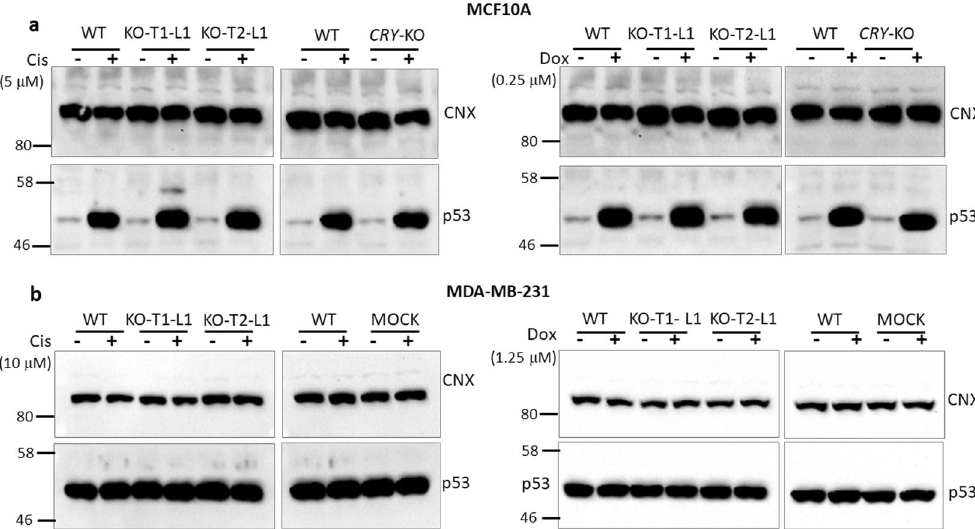
Figure 4. The effect of BMAL1 knockout mutation on p53 protein accumulation following cisplatin or doxorubicin treatment. ( a , b ) MCF10A and MDA-MB-231 cells express wild-type and mutant p53 proteins, respectively. BMAL1 mutation causes an increase in apoptosis in both cell lines while wild-type p53 accumulates at similar levels in wild-type and BMAL1 (as well as CRY -DKO) knockouts in MCF10A clones. A similar increase in apoptosis by BMAL1 mutations in untransformed (a) and transformed (b) suggests that this event is independent of the transformation status of the cells. A mock subclone (transduced with BMAL1 -targeting lentivirus but with wild-type BMAL1 ) of MDA-MB-231 was used as a control instead of CRY -DKO, because CRY -DKO on a p53 mutant background caused an increase in cisplatin-induced apoptosis in MDA-MB-231 cells, in agreement with previous reports (see Supplementary Data). Calnexin (CNX) served as a loading control. Numbers and marks on the left of each figure indicate the positions of the corresponding molecular size markers in kDa. KO indicates BMAL1 knockouts generated by T1 or T2 sgRNA targeting, L indicates subclone for each sgRNA targeting. Full-length blots are presented in Supplementary Fig. S11.